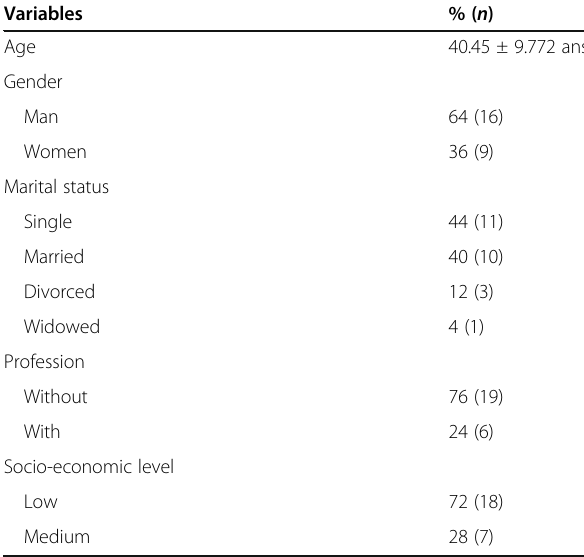
Table 1 Sociodemographic